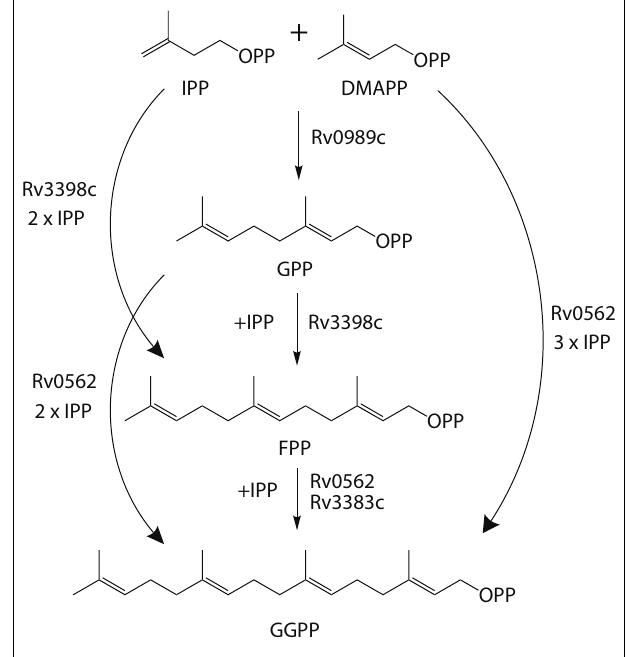
potential horizontal gene transfer products from an exogenous